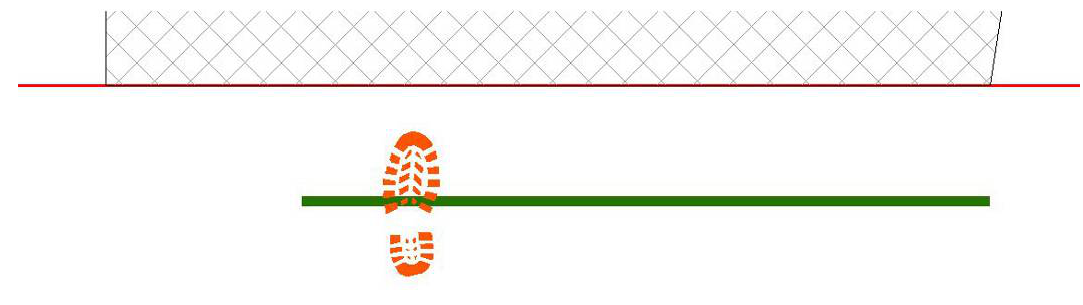
Figure 14 . Software workflow, step